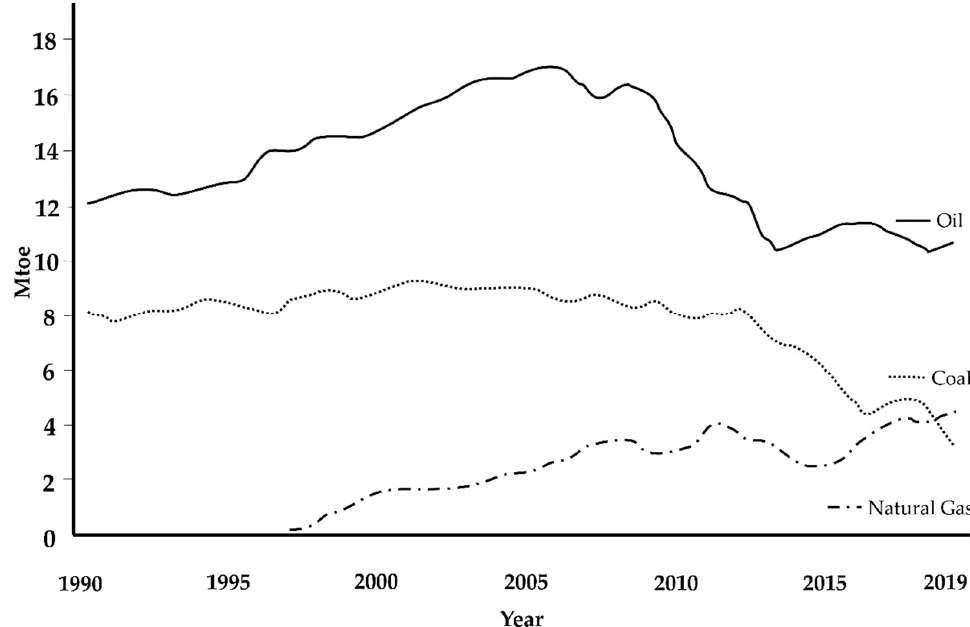
Figure 2. Total energy supply by source, Greece 1990–2019 (source: IEA, World Energy Balances 2020). During the same period, power generated from renewable sources has almost dou- bled [49]. Based upon the Greek National Energy and Climate Plan for 2030, the greenhouse gas emissions (GHGs) will be reduced 55% compared to those of 2005